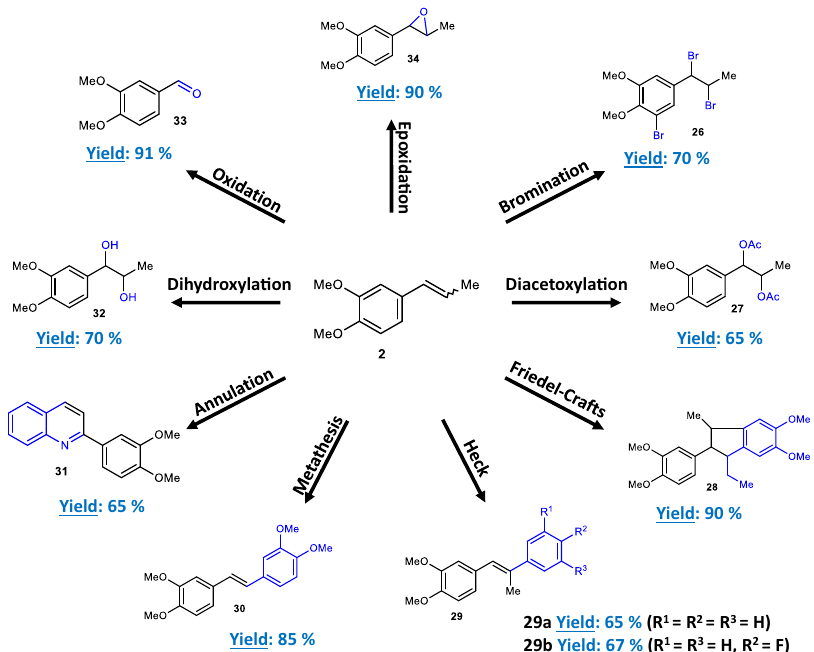
Fig. 5 One-pot reactions of the internal alkene product methyl isoeugenol 2. Representative reactions for internal alkenes were carried out in the same fl ask after the isomerization of 1 catalyzed by 10 ppm of Ru(methylallyl) 2 (COD). Isolated